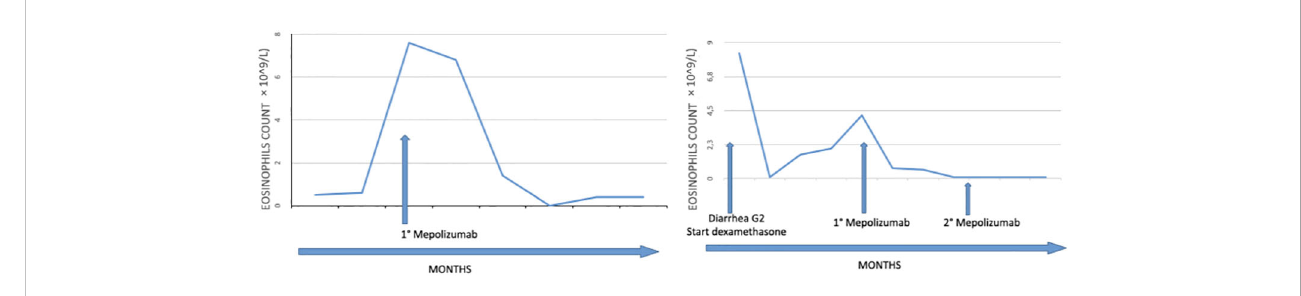
FIGURE 4 Timeline showing the clinical history of both